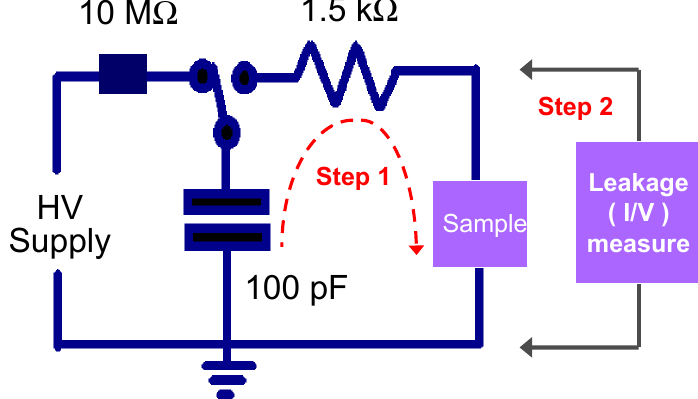
Figure 7. Testing procedures of an HBM ESD testing for UHV nLDMOS related devices.